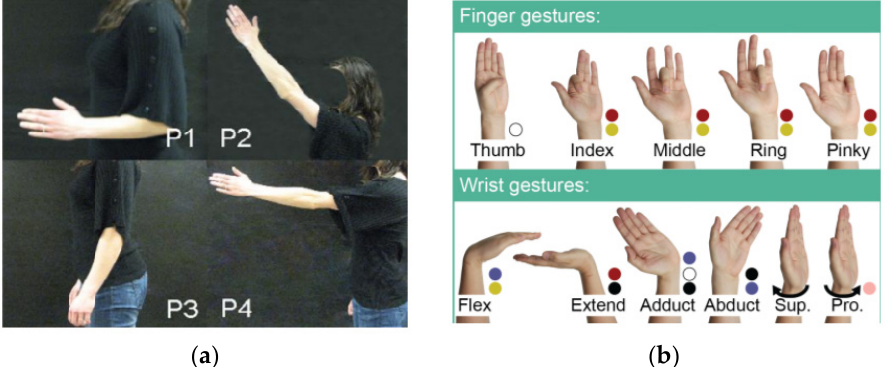
Figure 3. Two types of upper limb patterns. ( a ) the limb position, adopted from [25] . ( b ) hand gestures, adopted from [27] .